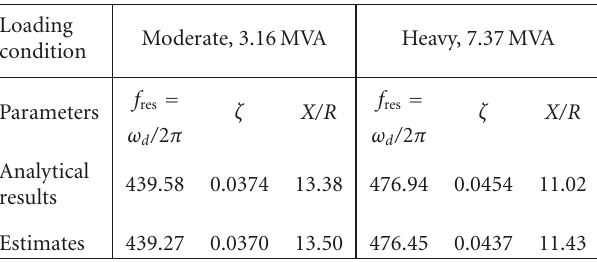
Table 5: Estimation results for nonlinear load.